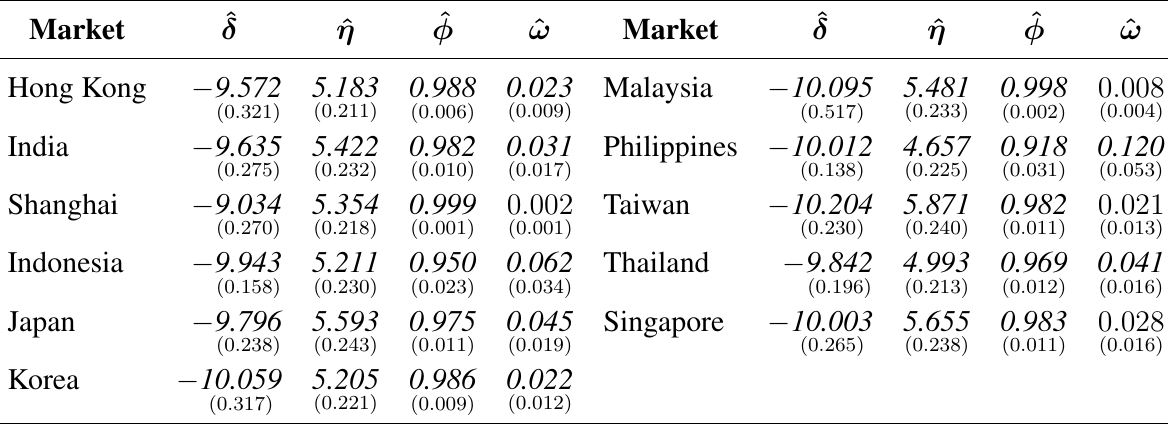
Table 6. Estimation results for the univariate SV